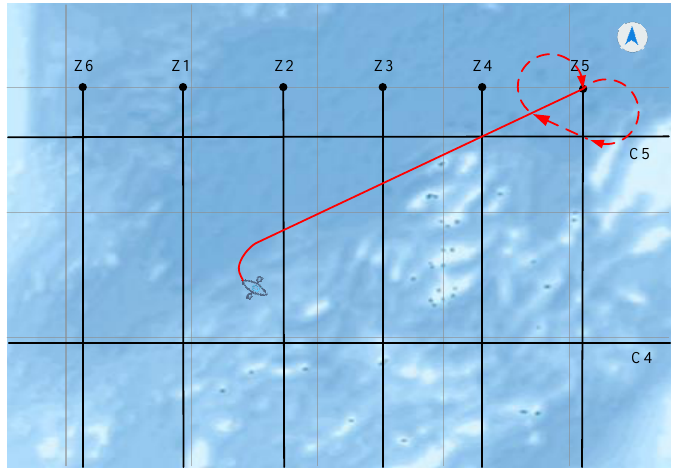
Figure 14. The route planned with the improved ant colony algorithm. The red solid line represents the planned route for the vessel to reach the starting point of the survey line, and the red doted line represents the planned route for the vessel to adjust its heading from the starting point of the survey line.